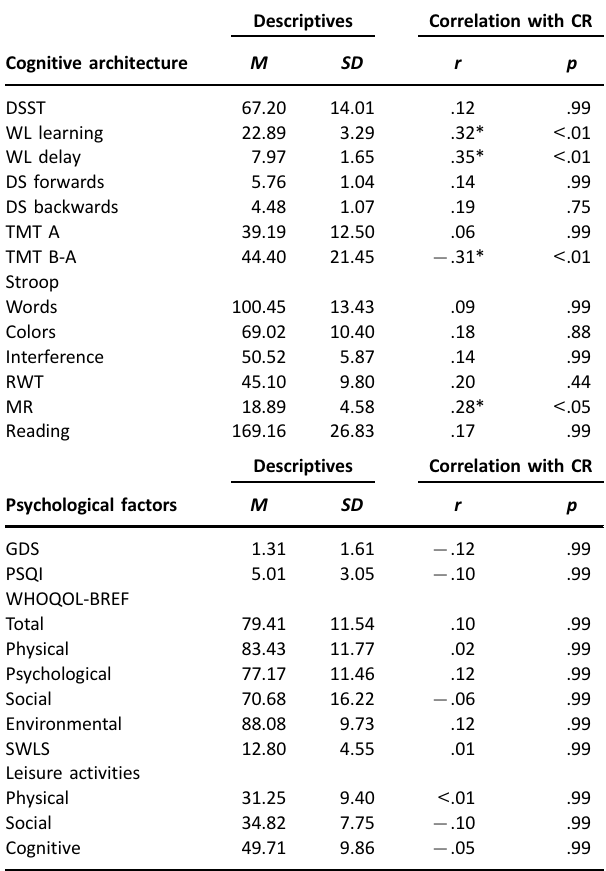
Table 1. Cognitive architecture and psychological factor